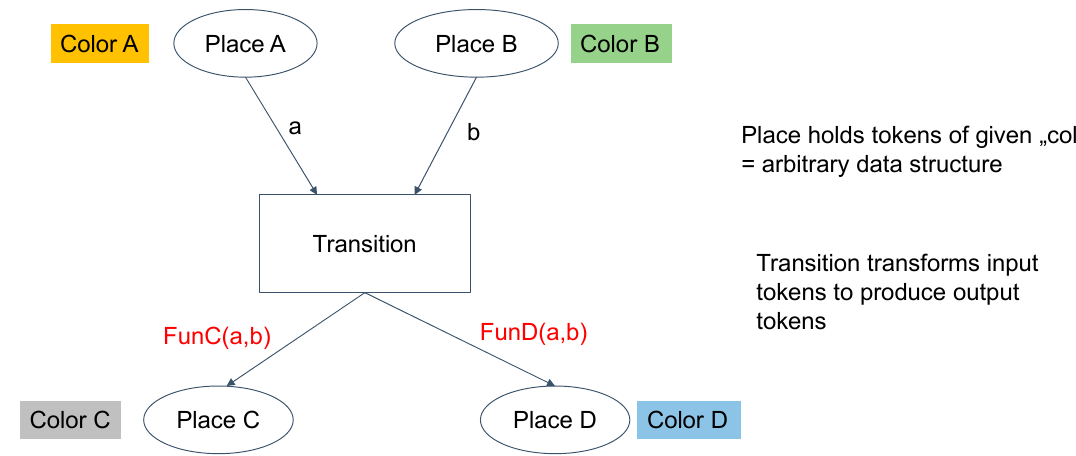
Figure 6. Fundamental concepts of Colored Petri Nets (CPN).